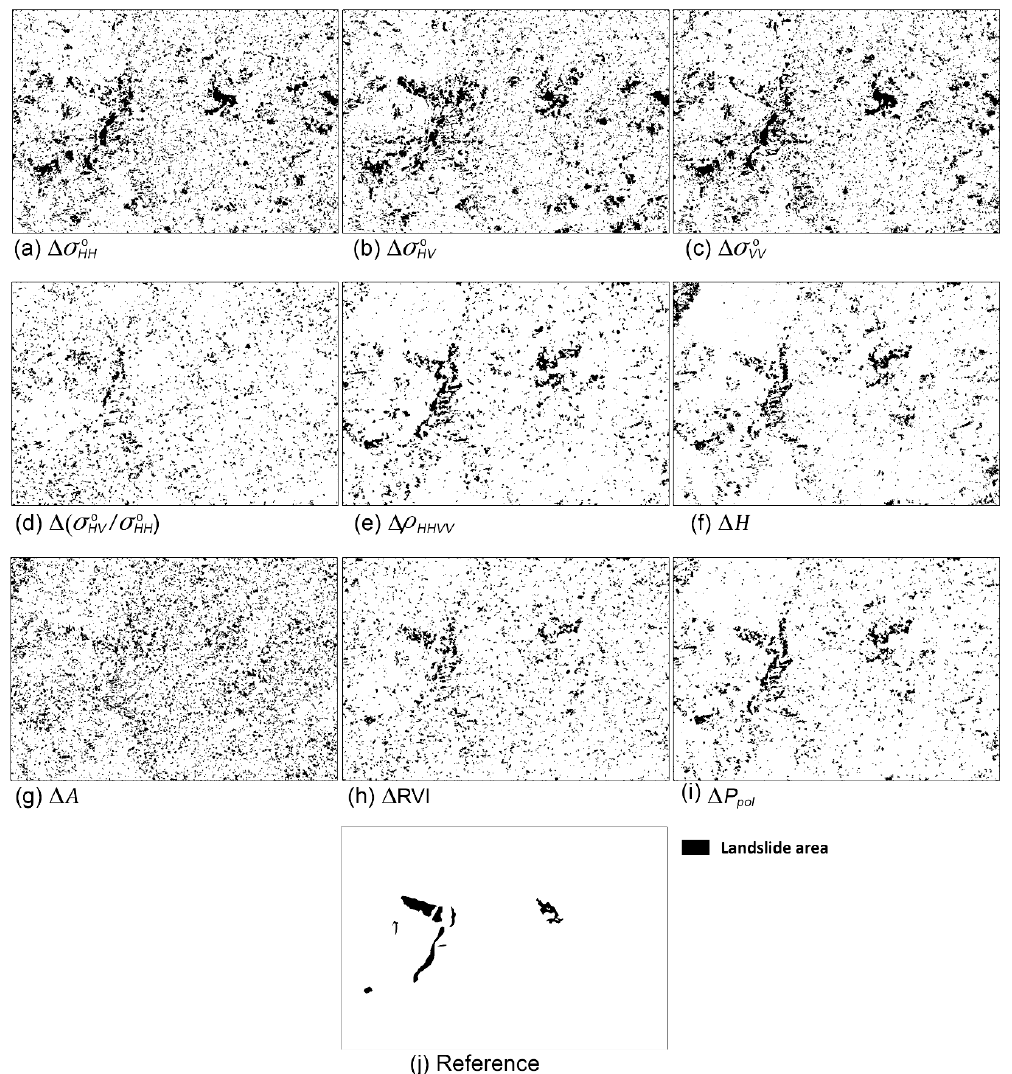
Figure 8. Landslide detection results obtained from different polarimetric parameters ( a - i ) and manually determined landslide areas ( j ).